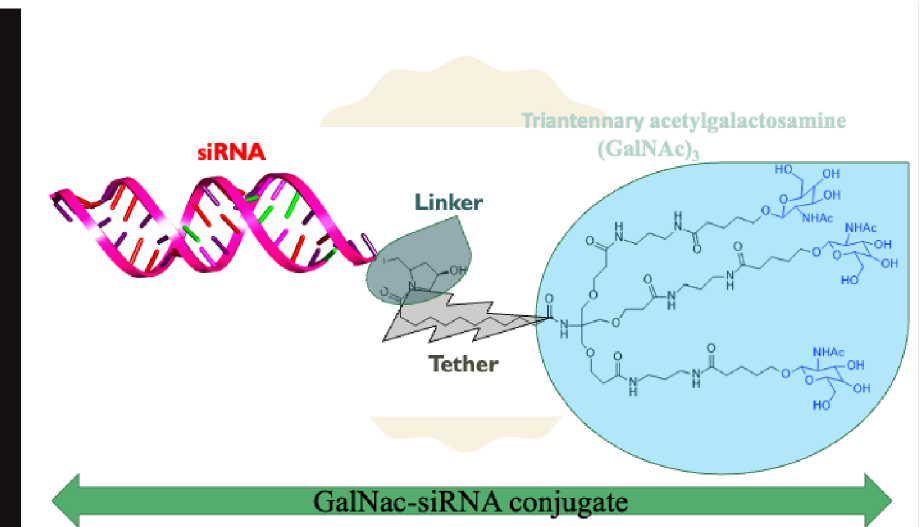
Figure 4. Chemical structure of triantennary acetylgalactosamine (GalNAc) 3 hybridized with